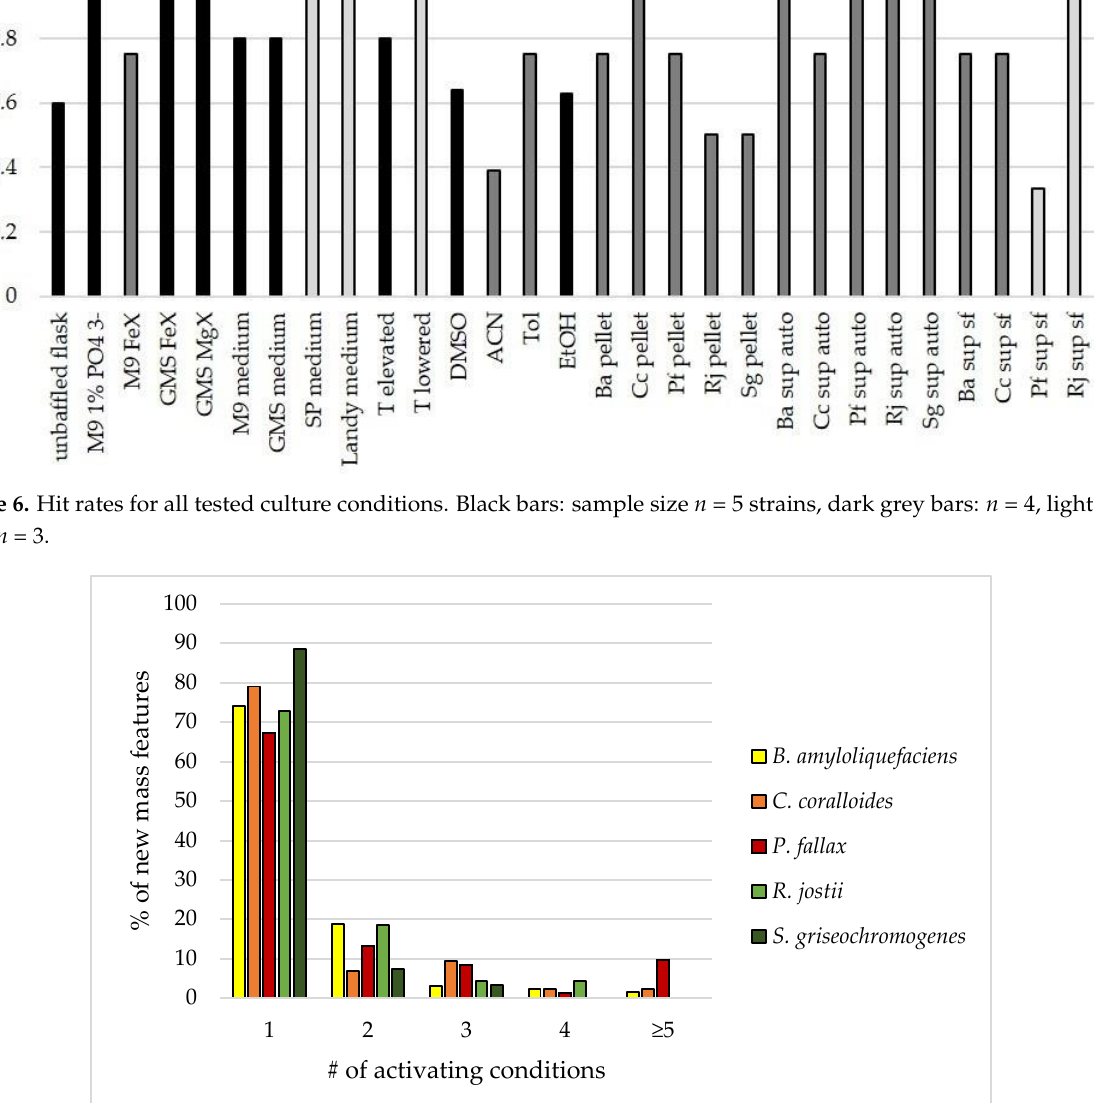
Table 7. Results of fragmentation pattern analysis of selected new mass features. The new mass features were identified by the fragmentation pattern library of the web-based mass spectrometry ecosystem Global Natural Products Social Molecular Networking (GNPS), MetFrag or a reference compound. Evidence is given in the Supplementary Material. A summary of the experimental fragmentation pattern is given in Table S27. The level of confidence for the identification of all compounds is given in Table S28. The ID is composed of the abbreviation of the producer strain (Ba = B. amyloliquefaciens , Cc = C. coralloides , Pf = P. fallax , Sg = S. griseochromogenes ) and the number of the detected new mass features. ID